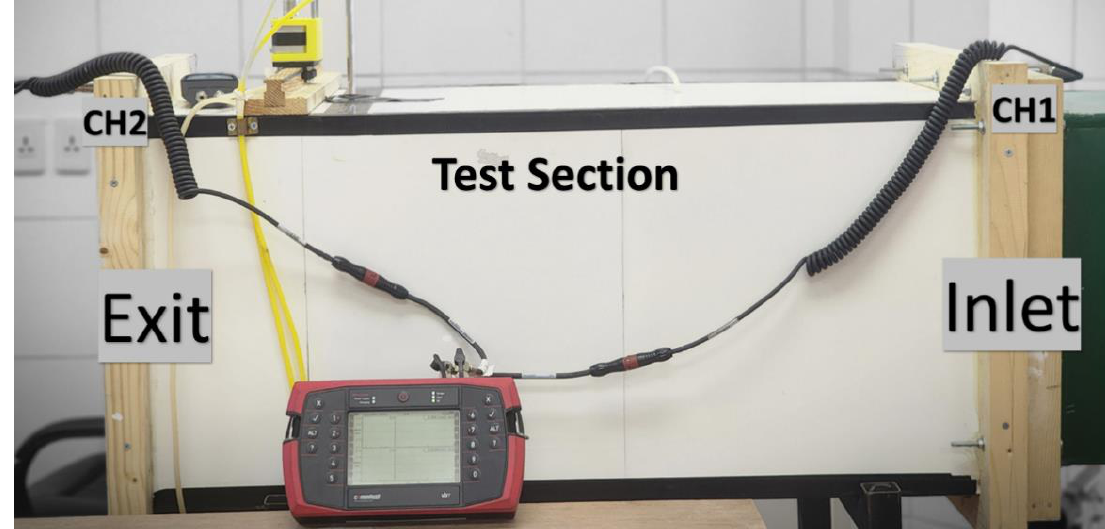
Figure 8. The structural vibration measurement using a vibration data collector with two-channel inputs.